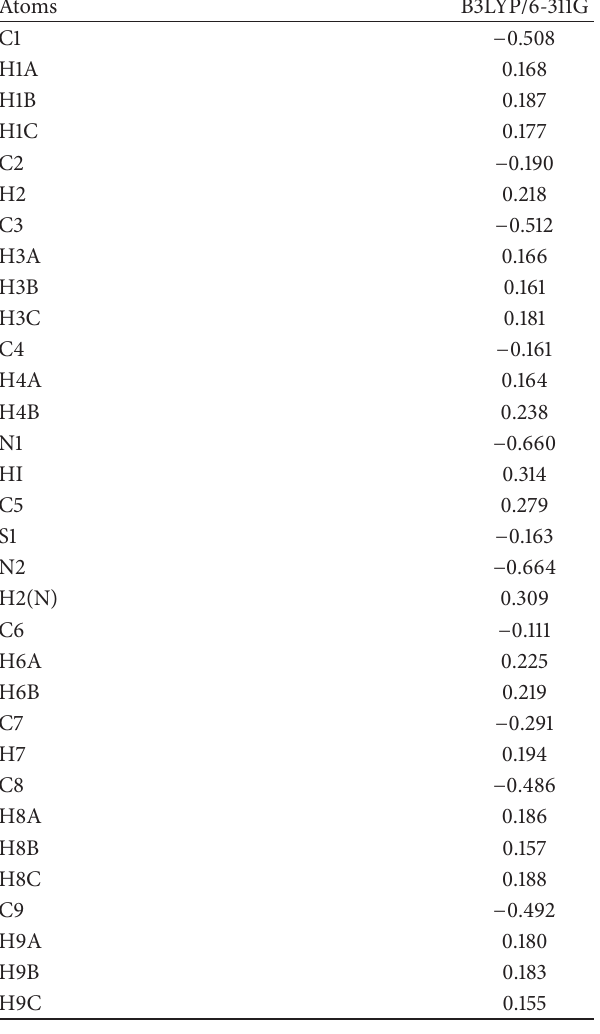
Table 5: Calculated Mullikan’s charges for B3LYP/6-311G.